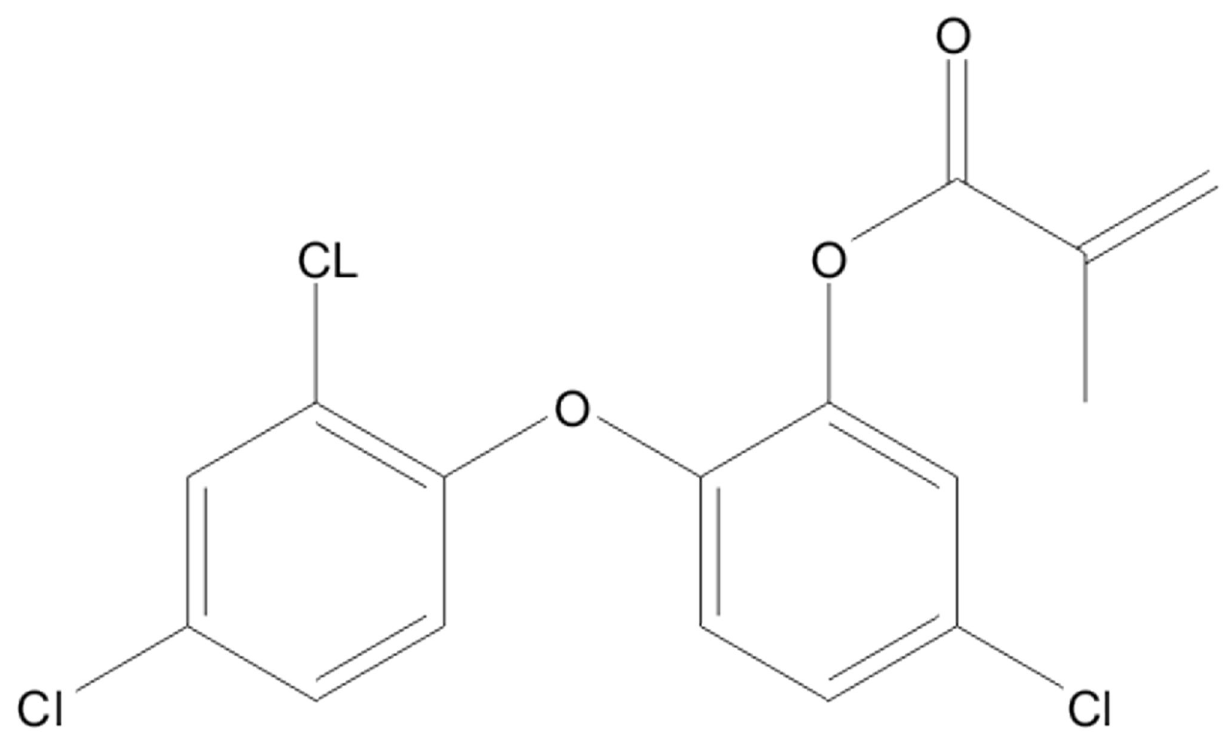
Figure 2. Chemical formula of